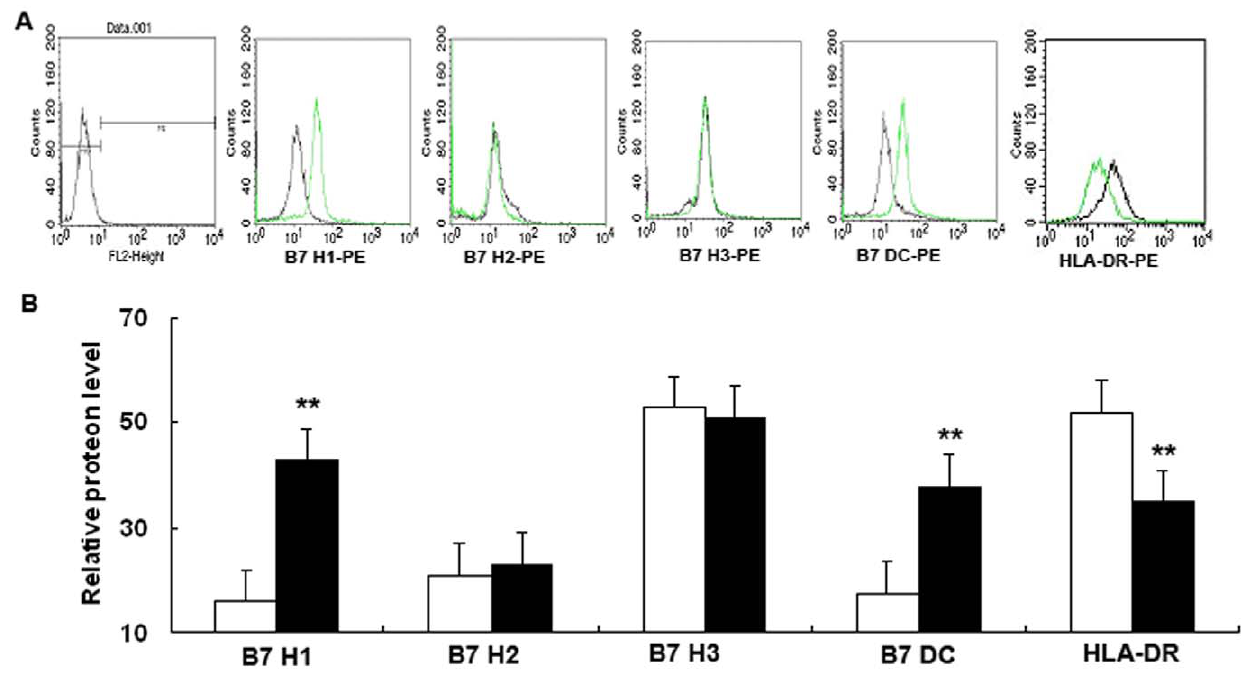
Figure 7. Flow cytometric analysis of cells surface expression of HLA-DR and B7 homologs in 16HBE14o- cells after ITGB4 silencing. (A) Cells from different groups were stained with specific antibodies to indicate HLA-DR and B7 homologs expression as described in materials and methods. The histograms shown are from a representative results of six independent experiments are shown. (B) The mean relative fluorescence intensity of B7 homologs was quantified after ITGB4 silencing.